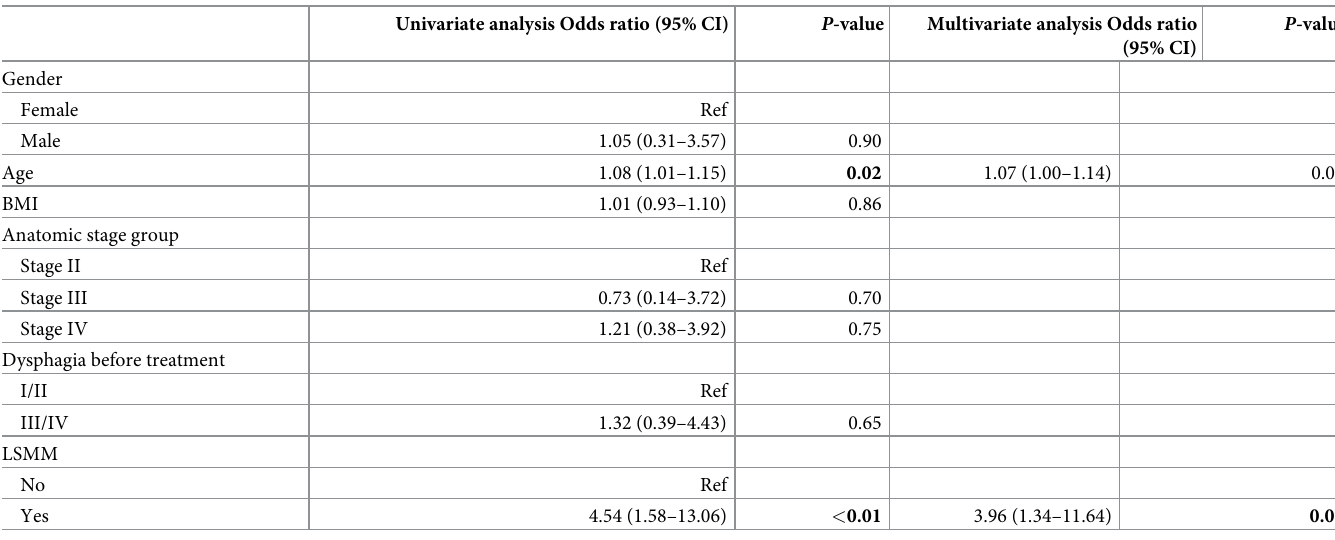
Table 4. Univariate and multivariate logistic regression for